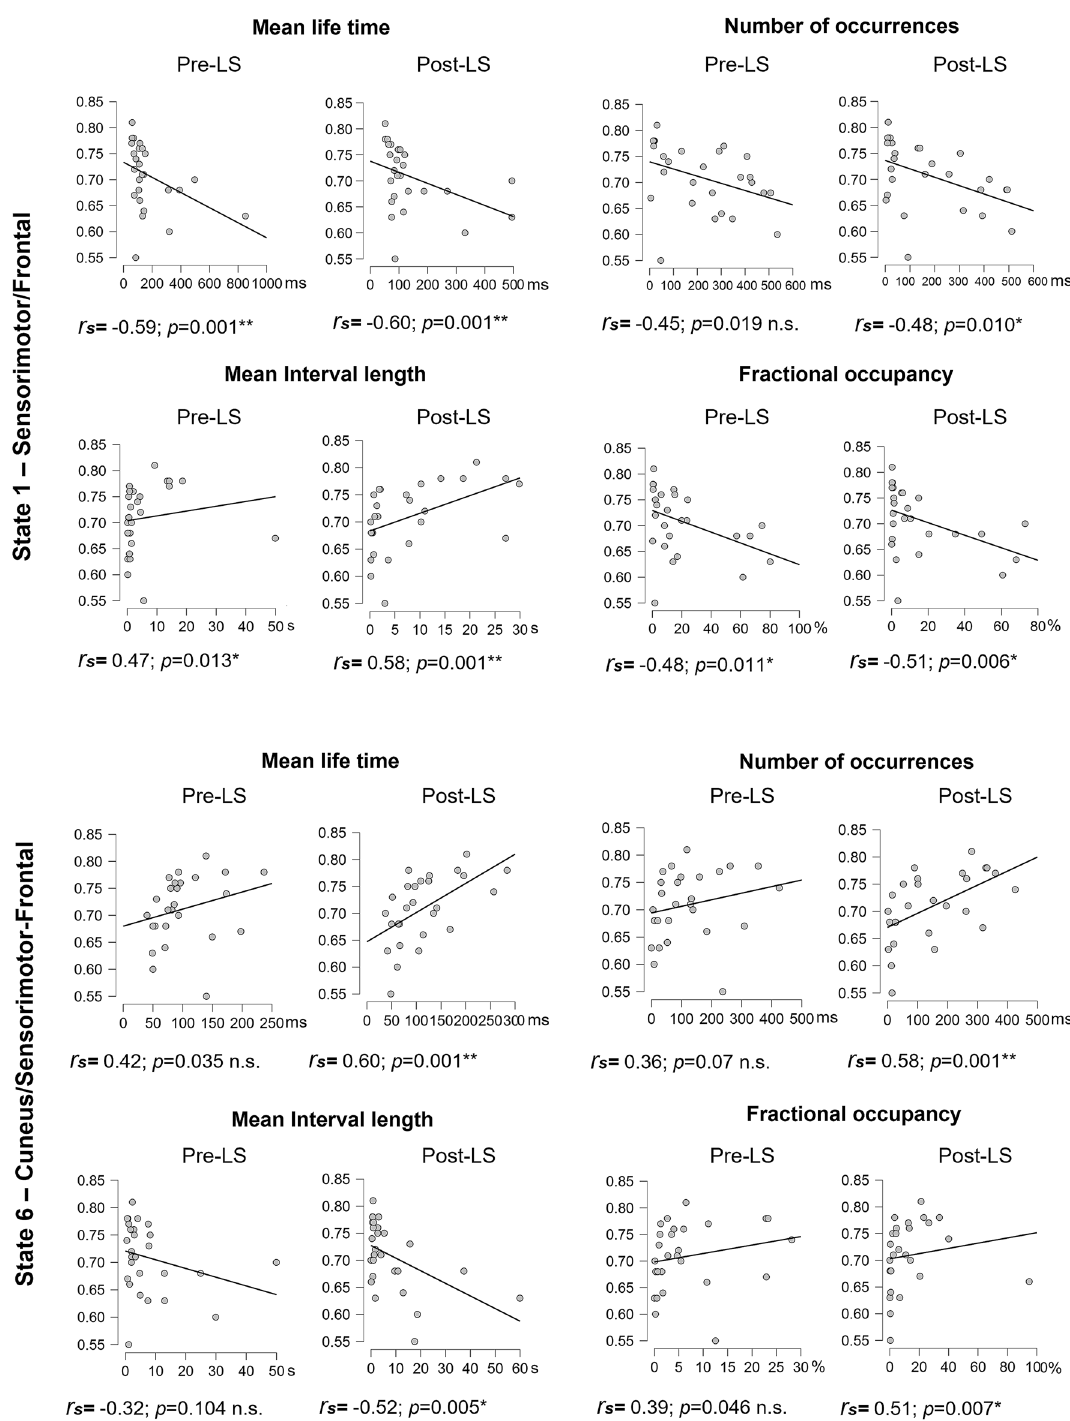
Figure 4. Correlations between best motor performance (BMP) achieved in the Learning session and HMM temporal parameters for States 1 and 6 before (Pre) and after (Post) learning (* p < 0.01 (corrected for 4 HMM temporal parameters); ** p < 0.002 (corrected for 4 HMM temporal parameters and 7 states). The figure was created using JASP version 0.14.1, JASP Team (2021), https:// jasp- stats.